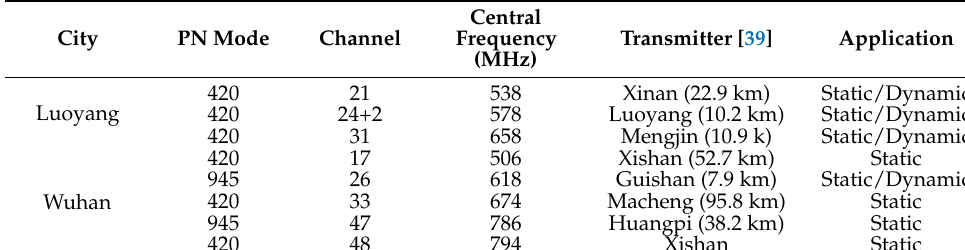
Table 1. Receiving details of the signal channel in field tests.